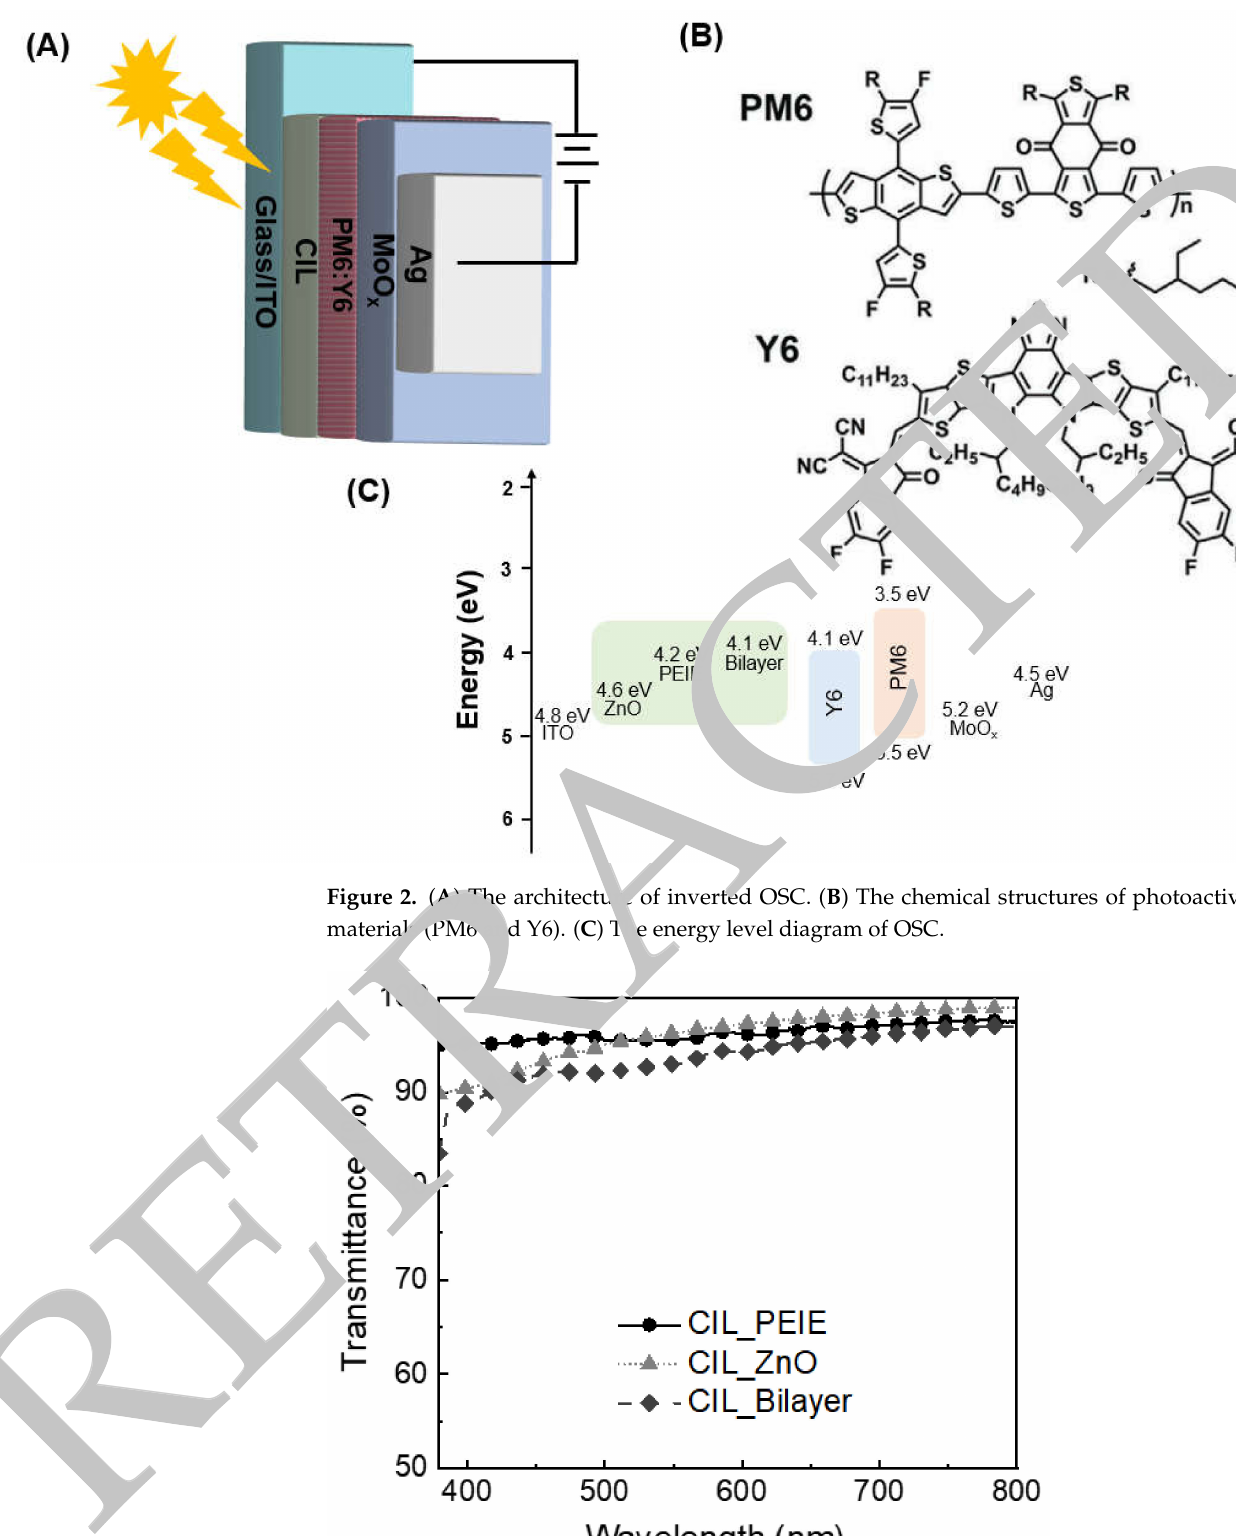
Figure 3. Transmittance spectra of various CILs investigated in this